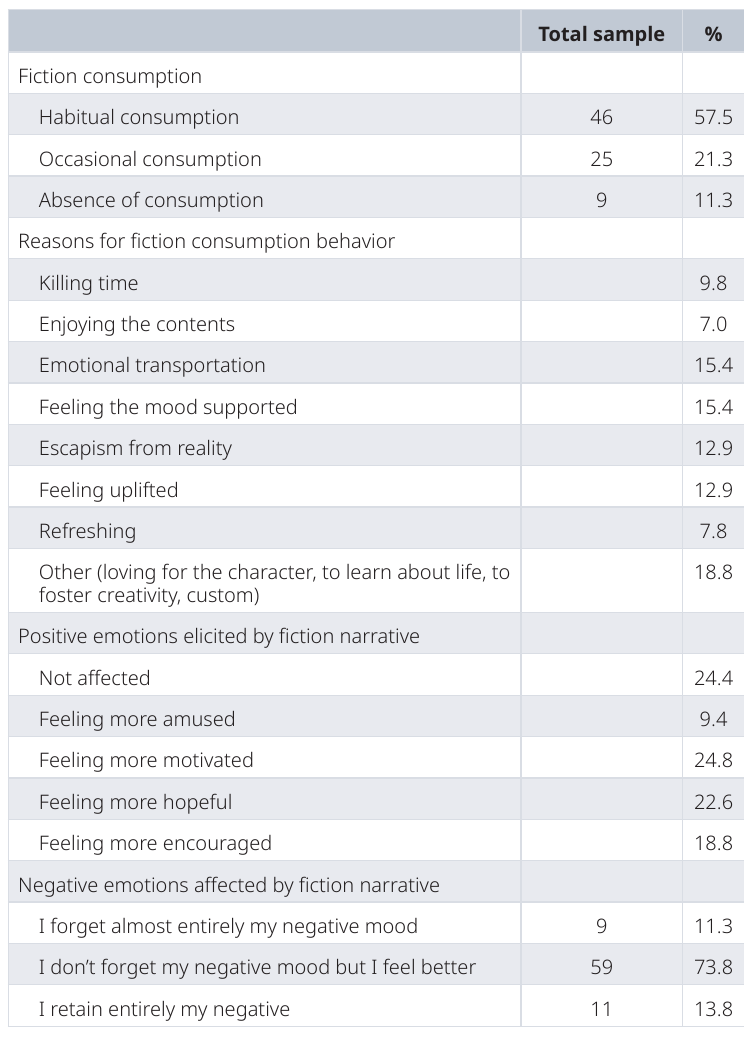
Table 2. Narrative consumption tendencies in